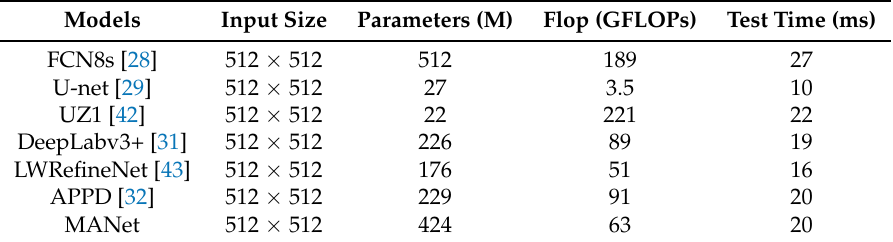
Table 5. The computation complexity of MANet and six other compared methods.